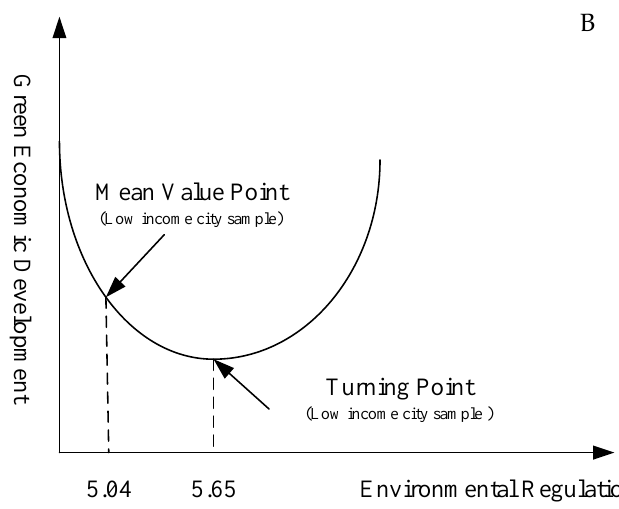
Figure 5. Nonlinear relationship between ER and GTFP. ( A ) Middle-level cities; ( B ) low-level cities.